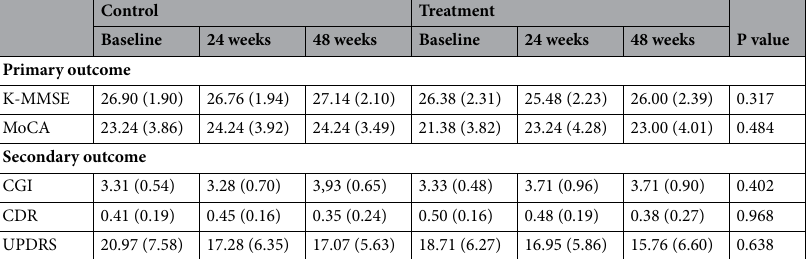
Table 2. Primary and secondary outcome measures. Data are expressed in mean (standard deviation). Data are results of linear mixed models for primary and secondary outcome measures. P < 0.05 means the significance of interaction effect between group and time. CDR clinical dementia rating, K-MMSE Korean version of mini-mental state examination, CGI Clinical Global Impression, MoCA Montreal Cognitive Assessment, UPDRS Unified Parkinson’s disease rating